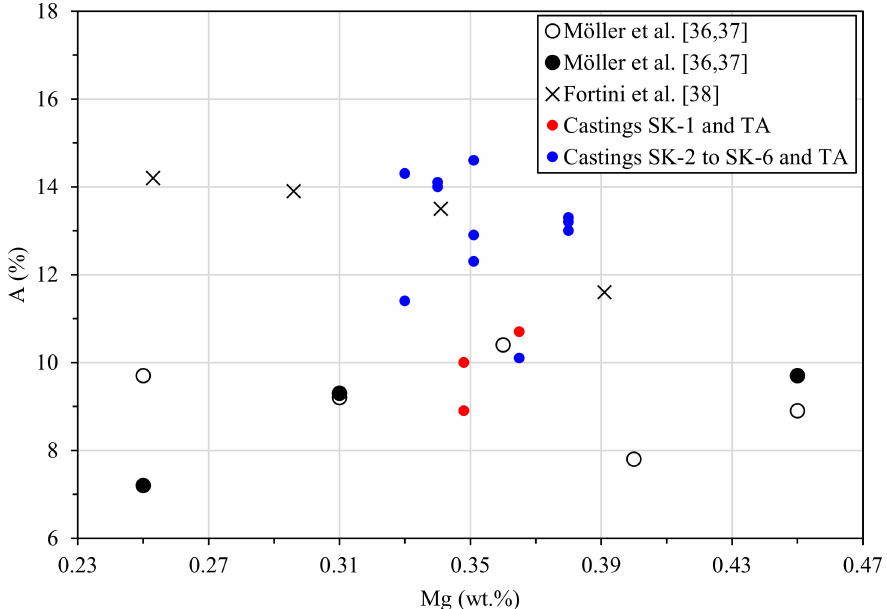
Figure 16. Evolution of A with Mg content for two series of SSM-A356 alloys from Möller et al. [36,37] and for one series of A356 alloys from Fortini et al. [38]. Red and blue symbols correspond to A values obtained from SK-1 to SK-6 and TA castings used in this work aged at 165 ◦ C for 280 min and at 155 ◦ C for 360 min, respectively (see the text).